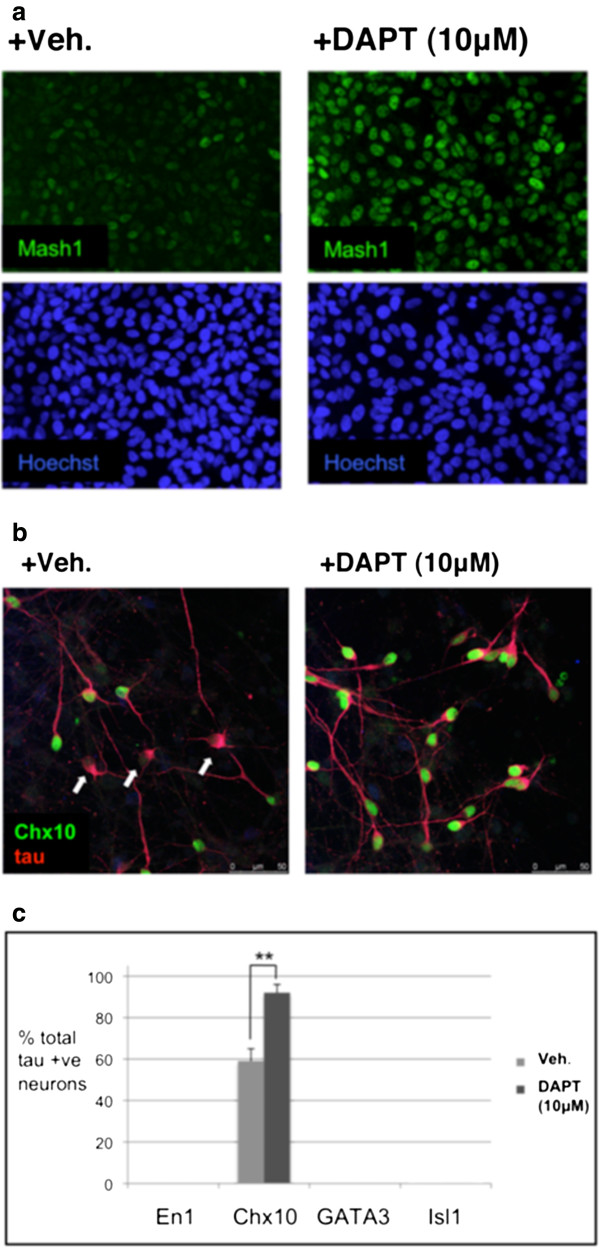
Notch inhibition regulates the fate of SPC-01. (a) Treatment of undifferentiated SPC-01 with the γ-secretase inhibitor DAPT (10 μM) for 48 hours upregulates MASH1 expression in SPC-01. (b, c) On differentiation, cultures of SPC-01 pretreated with DAPT for 48 hours gave rise to a significantly greater proportion of neurons with a CHX10+ V2a interneuronal phenotype (P < 0.01, means ± SEM, n = 3). This suggests that differential Notch signaling in the undifferentiated SPC-01 cells is giving rise to subpopulations of ventral interneurons, which can be directed into a V2a interneuronal fate by inhibition of Notch.